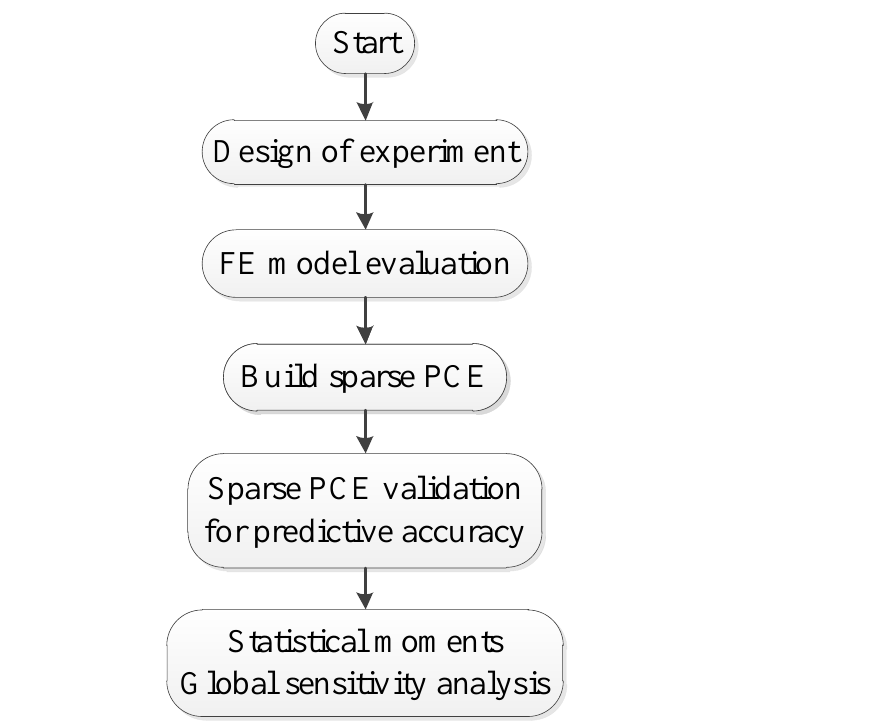
Figure 5. The flowchart for the data-driven sparse PCE.